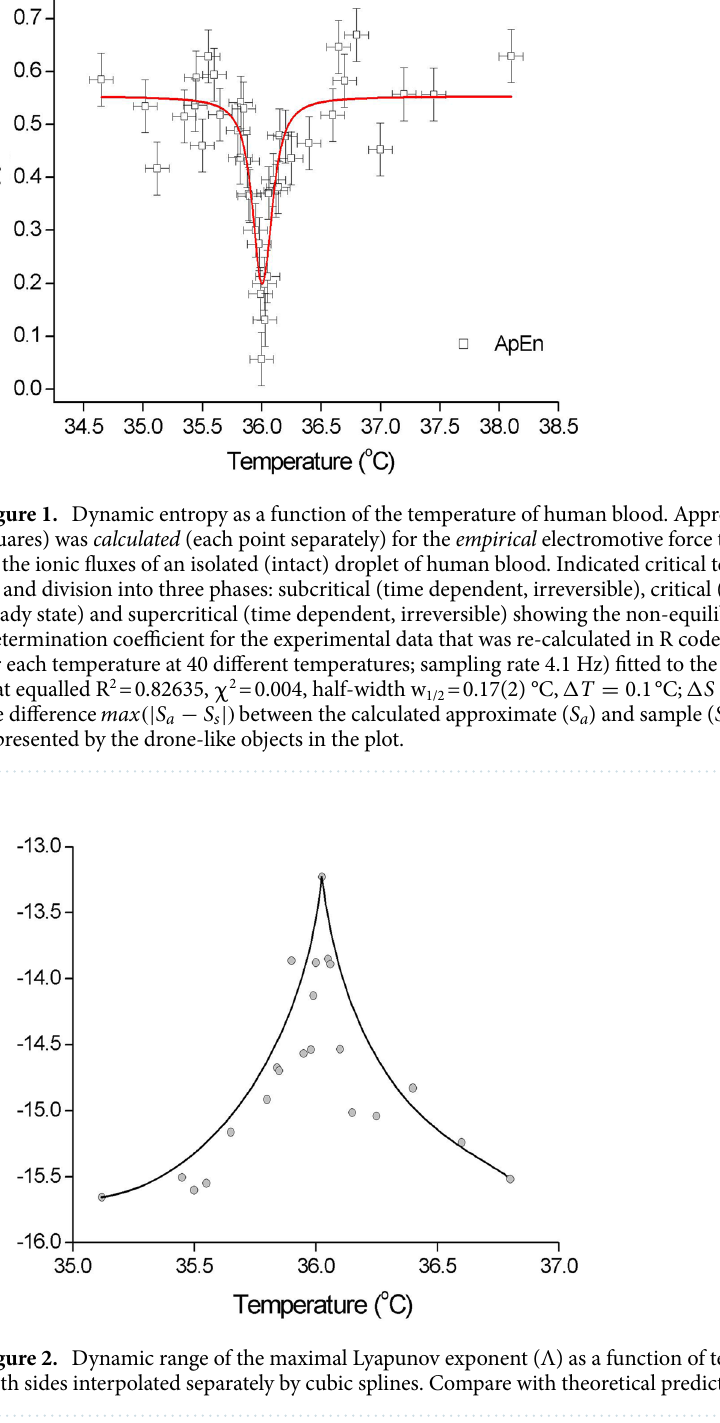
blood, weighted by the number N and N of populations involved in coherent sub-dynamics, Figs. S1-3e. The + − long-range cooperative interaction between live erythrocytes can be responsible for the non-vanishing electric N N polarisation field; thus the order parameter (cid:31) + − − N can characterise the asymmetric vacuum of the system = and consequently can be assumed to be the relevant order parameter in the sense of statistical mechanics. The results presented above, which converge to the same physiological temperature, are supported by Table S1 and Figs. S1-3 in the Supplementary Information, where the calculated complexity metrics are shown. There (Figs. S1-3), apart from the raw (a) and detrended (b) data the Hilbert transform (c) and the Hilbert-Huang envelope (d) in the Hilbert spectrum shows the resonance in the vibration signal, while the histogram (e) enabled the entropy of information 10 to be calculated. The autocorrelation function (f) and the mean mutual informa- tion (g) together with the calculated embedment dimension (h) enabled us to recreate (according to Takens’